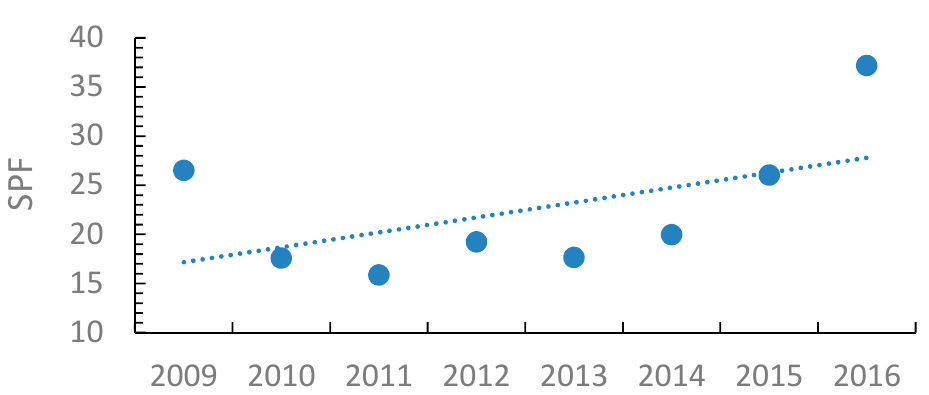
Figure 18. The SPF indicators for the Palestinian industrial sector between the years 2009 and 2016, where SPF = Number of working hours/days lost due to each occupational accident, regardless of its severity. Figure 19 classifies the Palestinian industrial sectors according to their seriousness, starting with the sector with the highest SPF and ending with the lowest SPF. The figure also shows the classification variations once FSI is used as a comparison indicator.